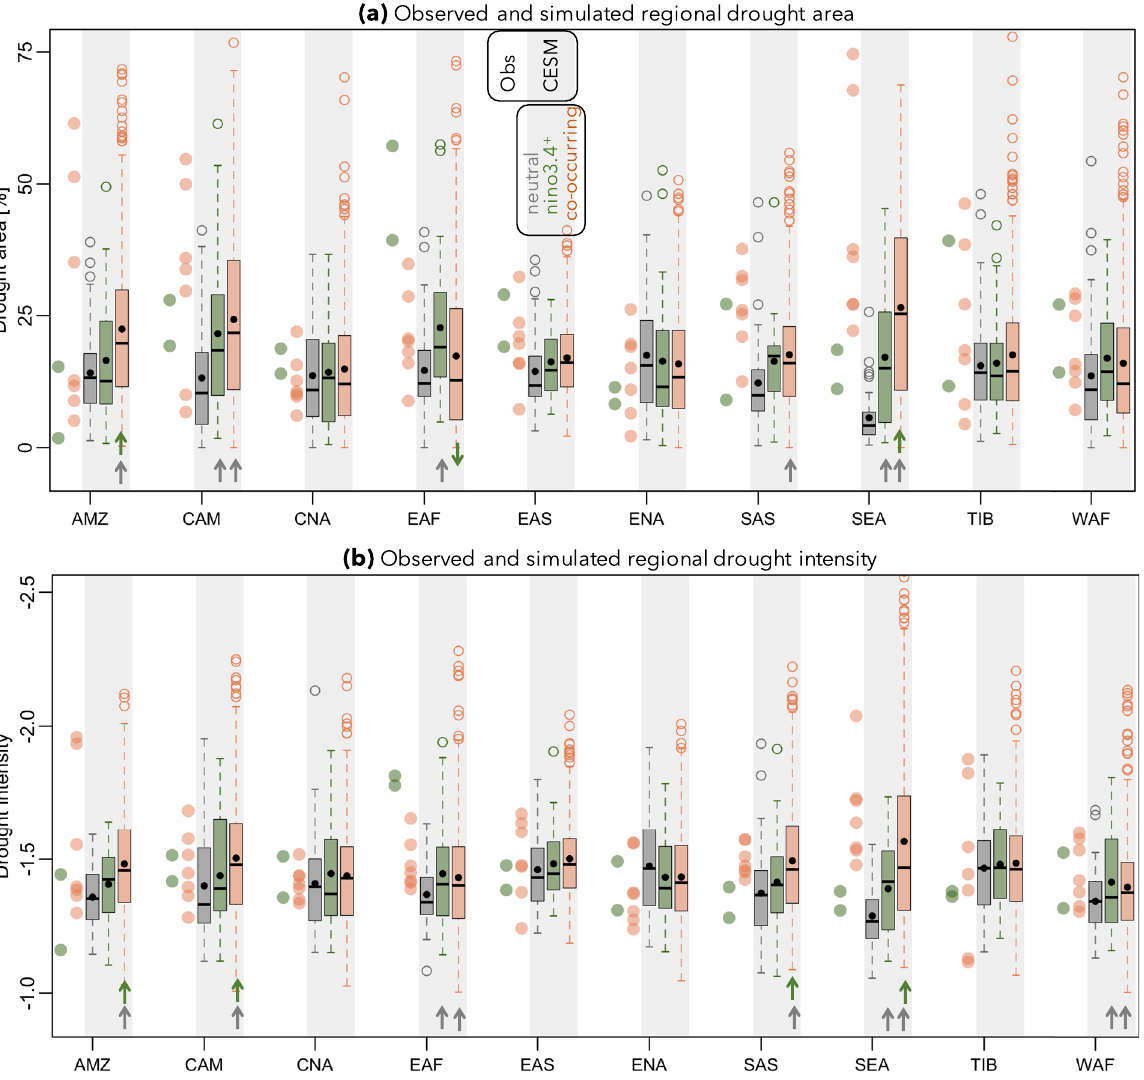
Fig. 3 In fl uence of El Niño and co-occurring modes of variability on regional drought characteristics. Observed (1981 – 2018; fi lled circles) and simulated (boxplots and un fi lled circles) distribution of a drought area and b drought intensity in each SREX region during neutral (gray), Niño3.4 + (green) and co-occurring (orange) conditions. Neutral conditions represent summer (June – September) seasons with neutral phases (< ± 0.5 σ ) of the four modes of variability considered. Niño3.4 + conditions represent seasons with SST anomalies >0.5 σ over the Niño3.4 region only and other modes in their neutral phases. Co-occurring conditions include summer seasons with Niño3.4 + conditions co-occur with either cold Atlantic Niño SST anomalies (< − 0.5 σ ), cold TNA SST anomalies (< − 0.5 σ ) or positive IOD (DMI >0.5 σ ) conditions, consistent with the phases of these modes that are associated with droughts in most regions. Gray arrows indicate signi fi cant differences in the mean of distribution of drought area and intensity during Niño3.4 + or co-occurring conditions relative to neutral conditions at 5% signi fi cance level. Green arrows indicate signi fi cant differences in the mean of distributions between Niño3.4 + and co-occurring conditions at 5% signi fi cance level. Black dots show the mean of the distribution in each boxplot. Signi fi cance of the difference in the drought characteristics between Niño3.4 + and co-occurring conditions in observations is not estimated due to small sample sizes. There are 2 Niño3.4 + and 7 co-occurring conditions in observations and 27 Niño3.4 + and 426 co-occurring conditions in the CESM pre-industrial EAF, SAS, and SEA relative to Niño3.4 + (Fig. 3b), consistent with relative to neutral conditions (indicated by gray arrows in Fig. 3a), while two regions — AMZ and SAS only show signi fi cantly larger observations (solid circles, Fig. 3b). Overall, these fi ndings high- droughts during co-occurring conditions but not during Niño3.4 + light the complex interplay of Niño3.4 + and other modes of ocean variability that control the spatial footprint and severity of over relative to neutral conditions (box plots, Fig. 3a). In addition, co- studies regions (Figs. 3 and S6). occurring conditions expand the drought area over AMZ and SEA While Niño3.4 + exhibits the strongest in fl uence on regional and signi fi cantly reduce drought area over EAF relative to Niño3.4 + (indicated by green arrows in Fig. 3a), consistent with precipitation characteristics, (Fig. 3 and S6), the frequency, severity observations (solid circles, Fig. 3a), highlighting their role in and spatial extent of compound droughts is substantially shaping drought characteristics. Moreover, Niño3.4 + signi fi cantly enhanced when Niño3.4 + co-occurs with other natural modes of increases drought intensity over EAF, SEA, and WAF relative to ocean variability (Fig. S7). For instance, the probability of neutral conditions. Further, co-occurring conditions are associated compound droughts in CESM increases from 0.09 during neutral with signi fi cantly higher drought intensity over AMZ, CAM, WAF, conditions to ~0.27 during Niño3.4 + conditions and ~0.43 during